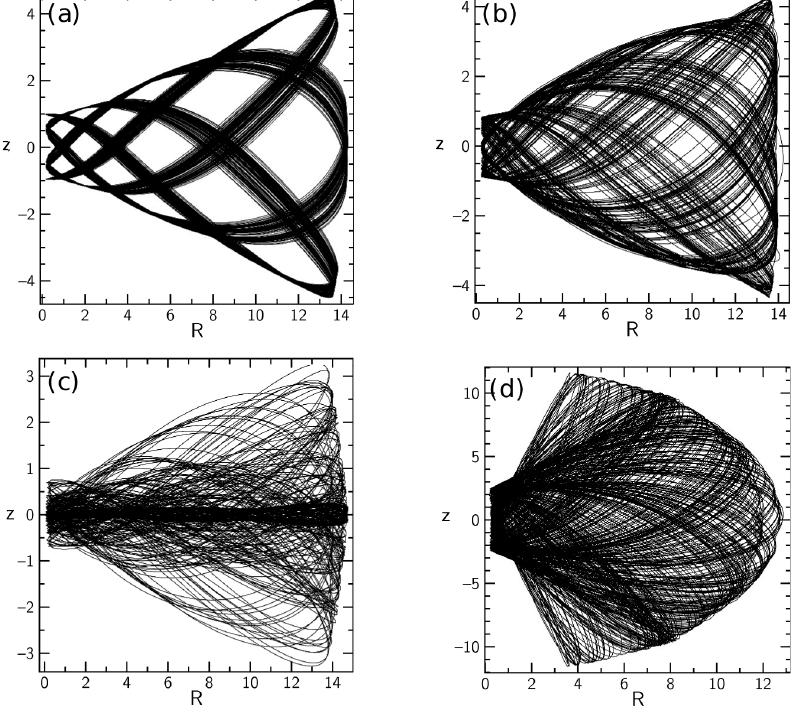
Fig. 7. The shape of the orbit discussed in Fig. 6c in four time intervals of the galactic evolution. (a-upper left): 0 (cid:20) t (cid:20) 500; (b-upper right): 3500 (cid:20) t < 3700; (c-lower left): 3700 (cid:20) t (cid:20) 4100; (d-lower right): 8000 (cid:20) t (cid:20)